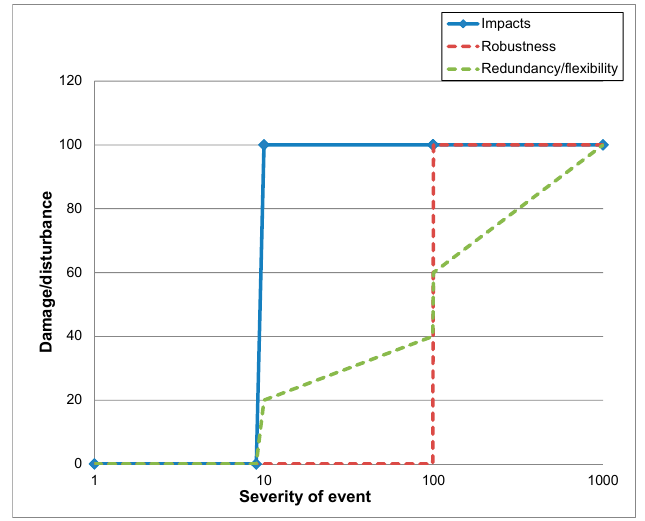
Figure 3. Severity ‐ disruption relationship for a reference system and a system with added robustness, redundancy, and flexibility.